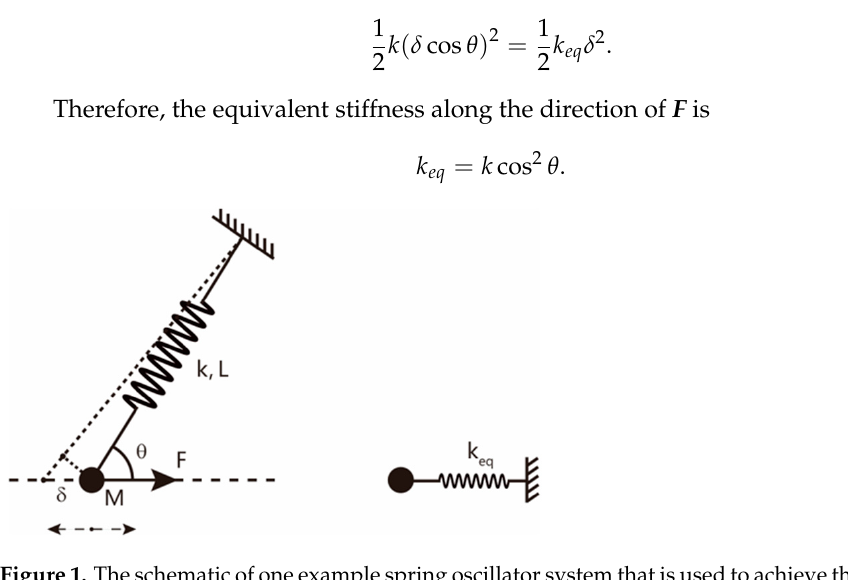
Figure 1. The schematic of one example spring oscillator system that is used to achieve the equivalence of the stiffness.